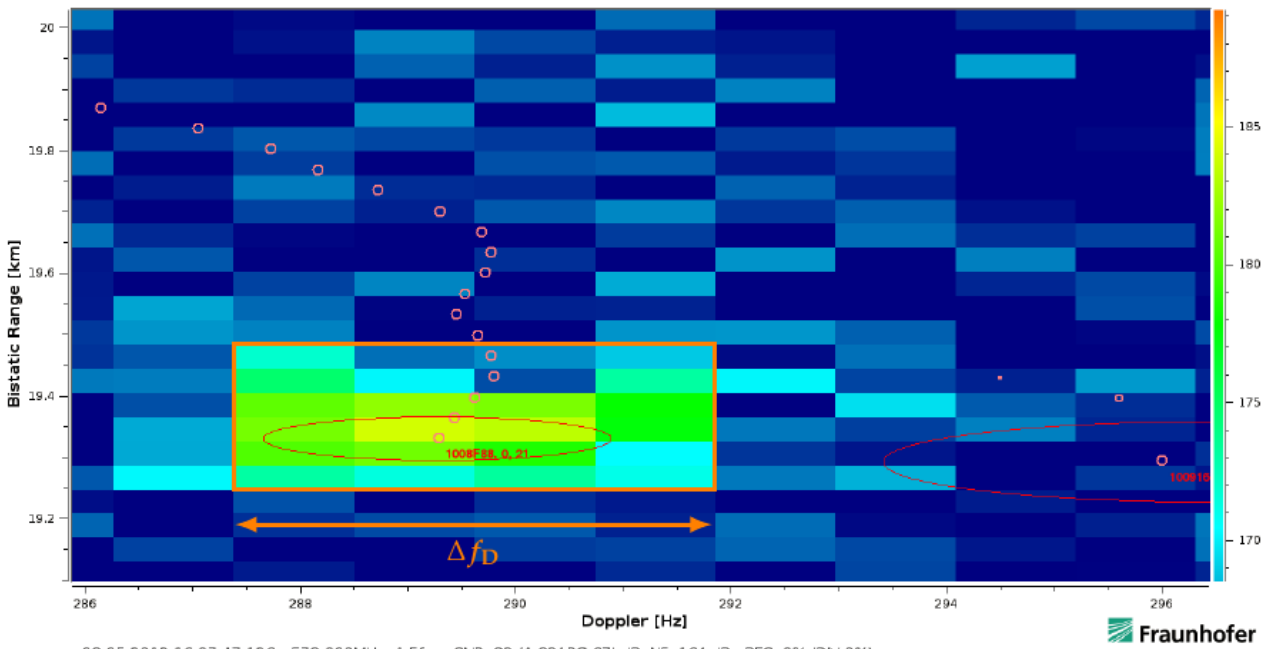
Figure 5. Target tracked with an approximately constant effective bistatic velocity v ≈ 270km/h and T cov = 896ms with T int = 717ms, spread fluctuations led to a detached track visible on the right